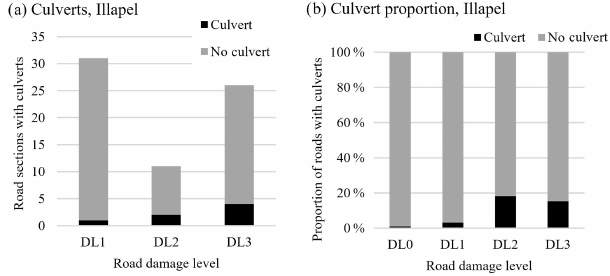
Figure 7. Number (a) and proportion (b) of road sections with or without a culvert, by damage level, for the 2015 Illapel earthquake and tsunami. Note: DL0 had a count of 573 road sections (too many to represent in panel a ), with 5 having a